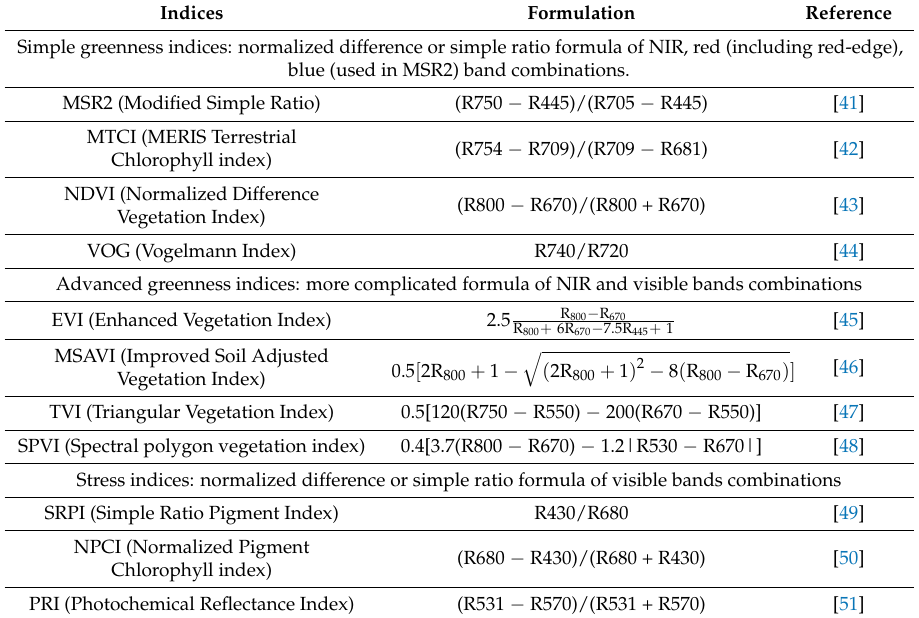
Table 2. Vegetation indices, proposed in the relevant literature, that were tested in the present study. Indices Formulation Reference Simple greenness indices: normalized difference or simple ratio formula of NIR, red (including red-edge), blue (used in MSR2) band